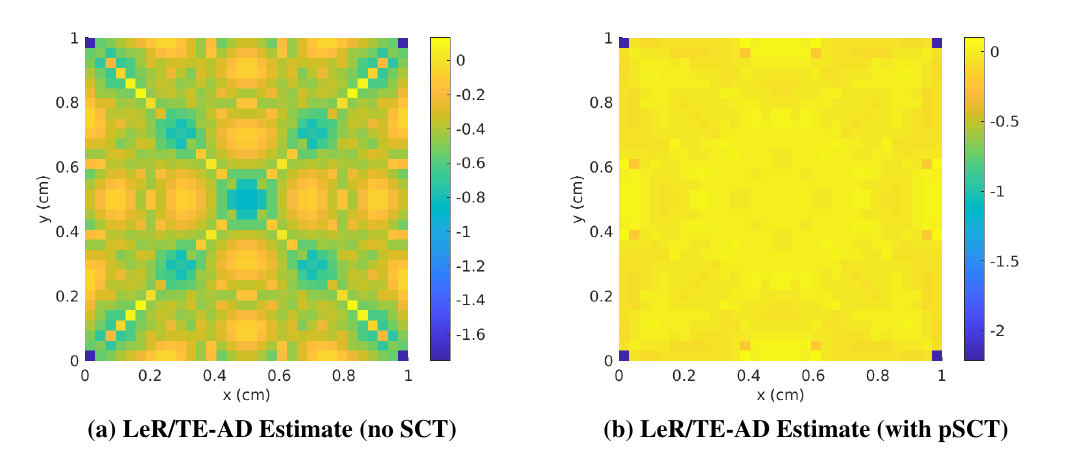
θ ( i,j ) on Problem Figure 6: log 10